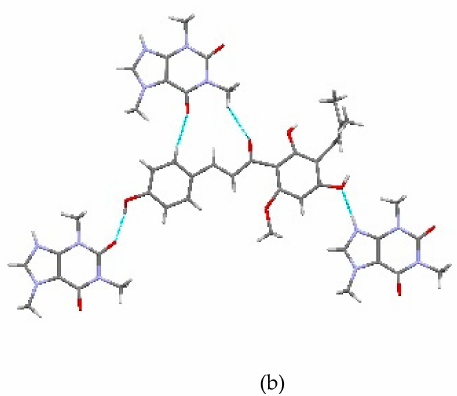
Figure 9. ( a ) Weakly bonded layers in the XN − CF cocrystals; ( b ) the in-plane of the XN layer hydrogen bonds. It can be seen that one XN molecule (green) is surrounded by three ca ff eine moieties